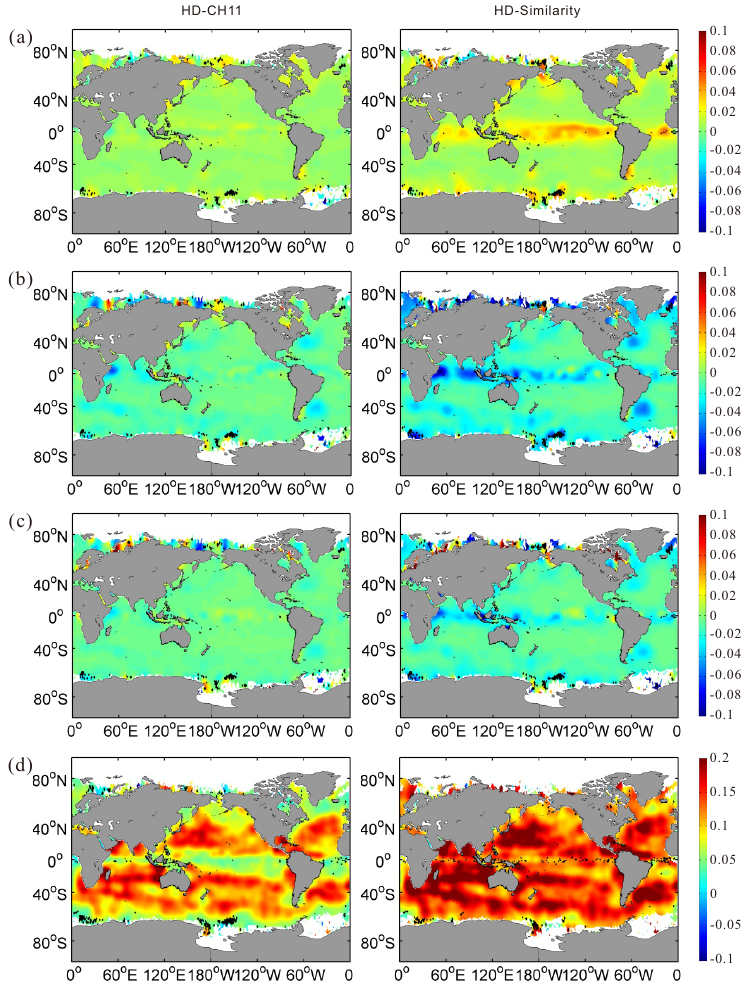
Figure 11. Relative differences in the average eddy properties of ( a ) radius (km); ( b ) amplitude (cm); ( c ) rotational speed (cm/s) and ( d ) lifespan (days) between the hybrid and CH11 methods and the hybrid and similarity methods(left to right)for eddies with lifespans longer than 10 days in each 1 ◦ × 1 ◦